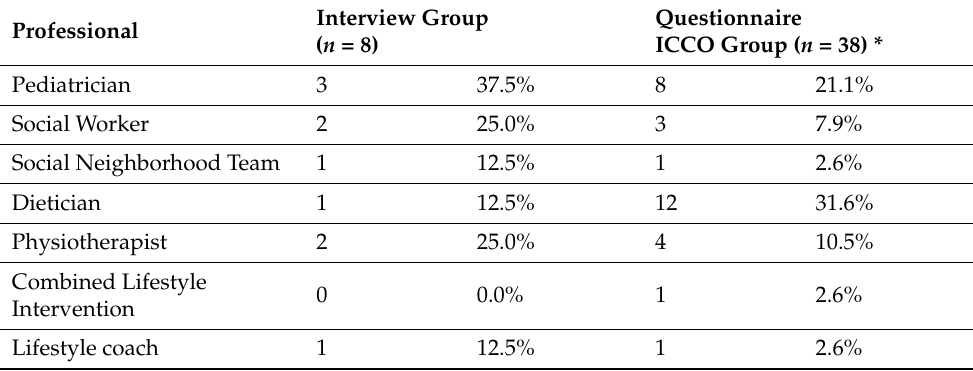
Table 2. Families’ contact with other professionals last